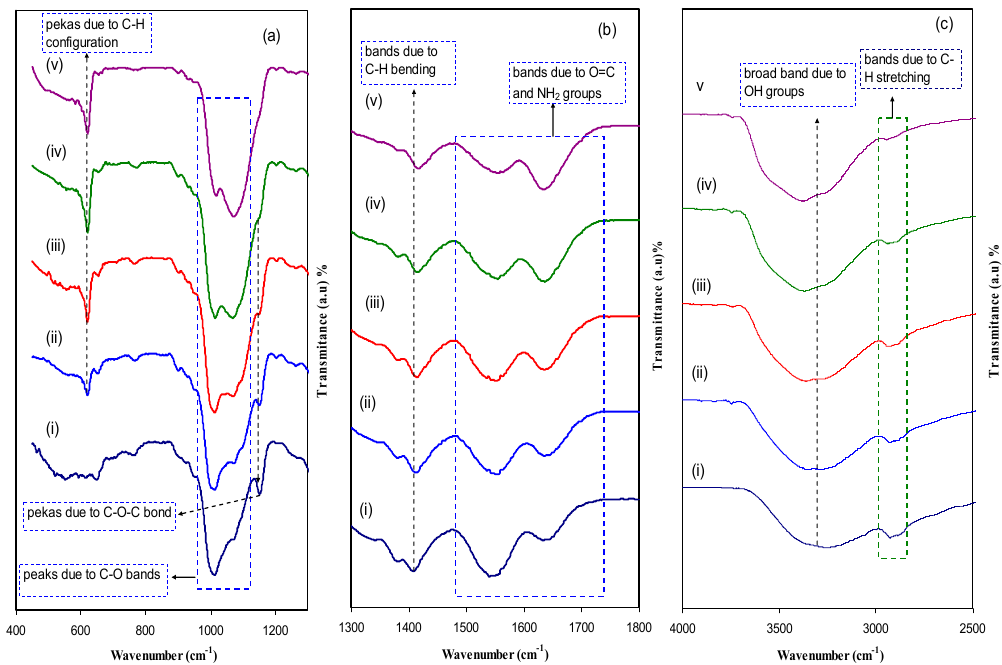
Figure 3. FTIR spectra of (i) CS:Dextran (pure film), (ii) CSDPB1, (iii) CSDPB2, (iv) CSDPB3, and (v) CSDPB4 in the region ( a ) 700 cm − 1 to 1300 cm − 1 , ( b ) 1400 cm − 1 to 1800 cm − 1 , and ( c ) 3000 cm − 1 to 3800 cm − 1 .